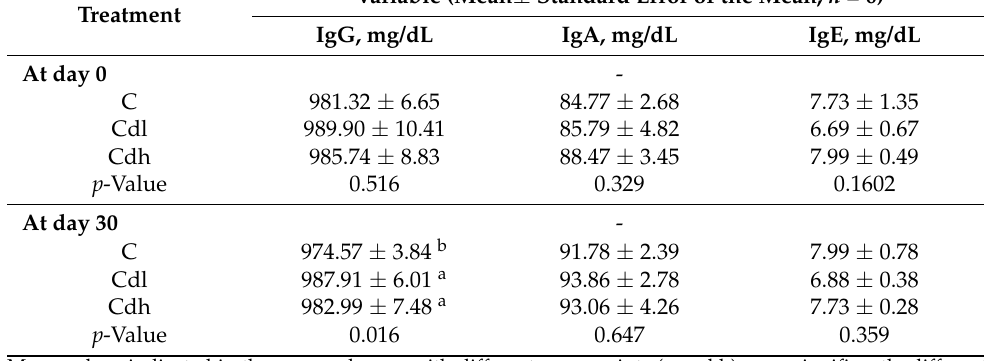
Table 7. Humoral immune indicators (immunoglobulins (Igs)) of rabbits treated with different concentrations of Cleome droserifolia (Forssk.) Del. (Cd) (0: C, Cdl: 1.25 g/kg of DM diet, or Cdh: 2.5 g/kg of DM diet).